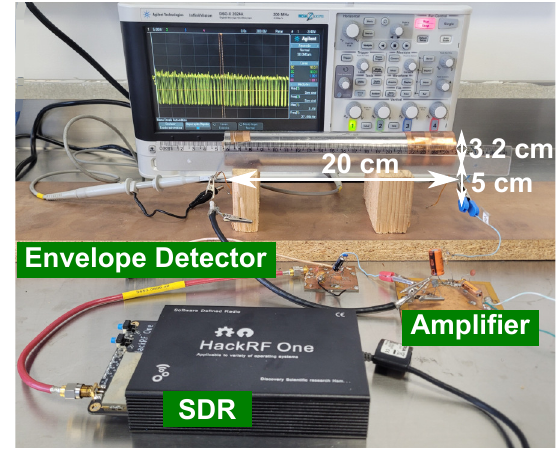
FIGURE 9. Complete test circuit, with the DUT